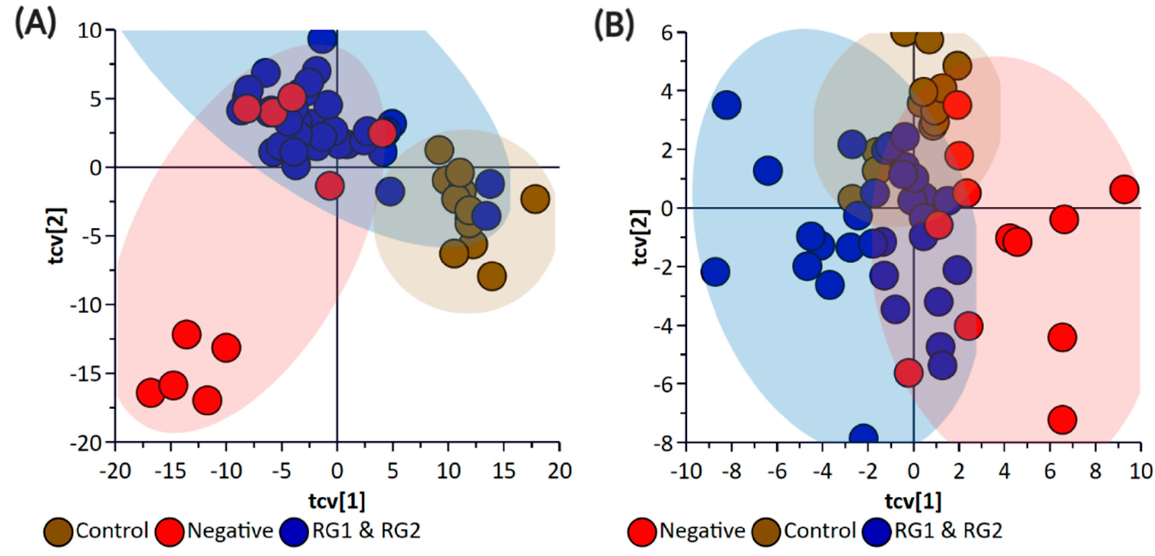
Figure 8. OPLS-DA Cross-Validation Scores plots for ( A ) bacterial pellet and ( B ) bacterial supernatant samples collected from inoculated spinach ( n = 58; note, the negative group includes Salmonella ). The F-test statistic and p -value based on a CV-ANOVA were 7.13 and <0.0001 for the pellet samples, and 3.9 and <0.0001 for the supernatant samples, respectively. Note: The colored circles in each panel represent each analyzed sample, and any overlap of the deviation of the samples from the origin (0,0) indicates the potential of the model to misclassify sample groupings.